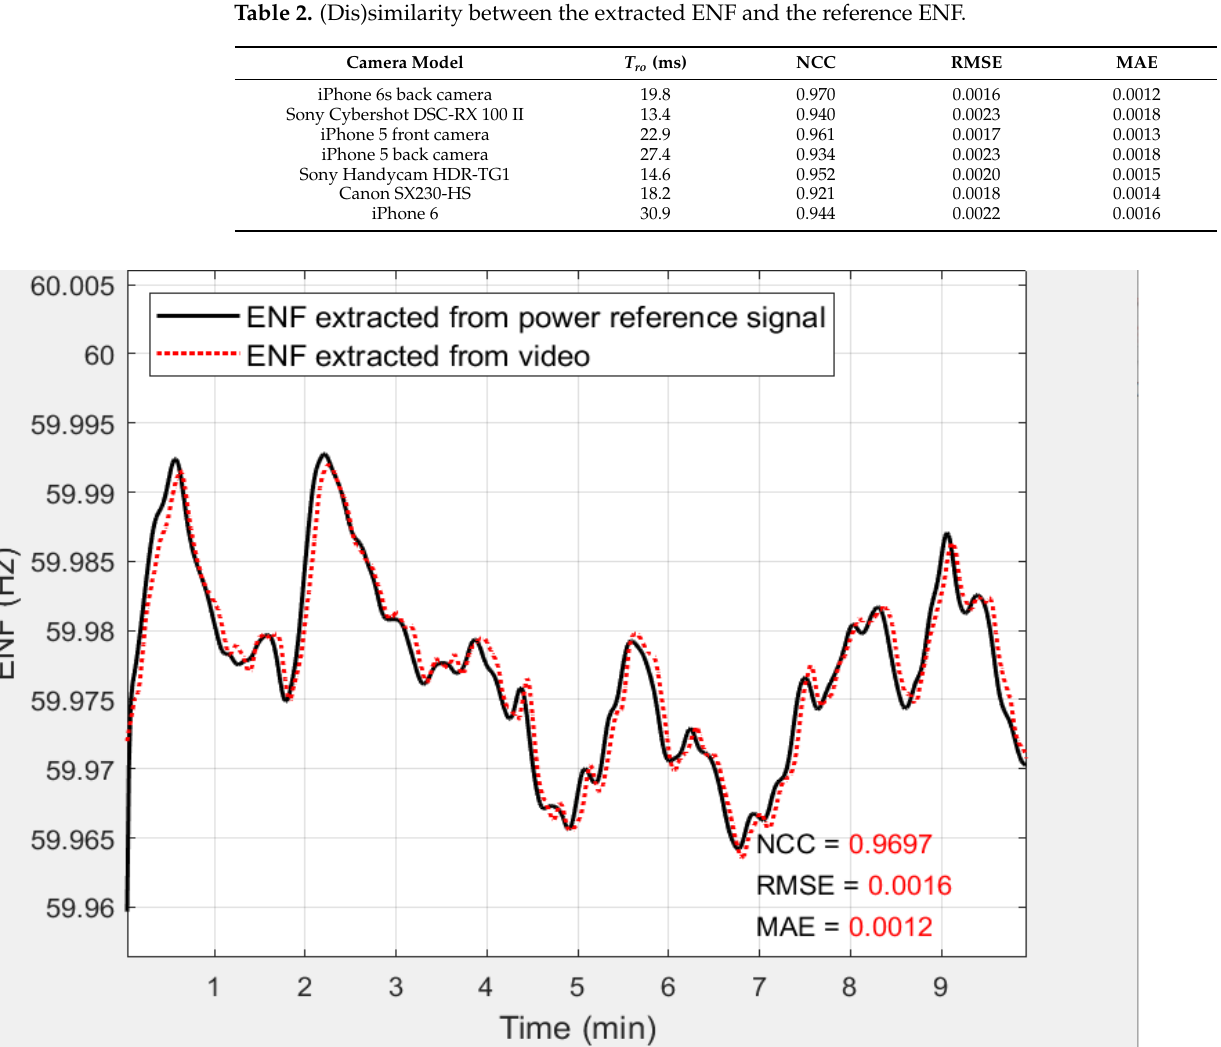
Figure 6. Sample of the ENF signal extracted from a video file (red) using a 𝑇 𝑟𝑜 value of 13.4 ms (Sony Cybershot DSC-RX 100 II) and matched against the reference signal (black). The bottom right corner shows the measure of similarity and dissimilarity between the extracted signal and the ref- erence signal.